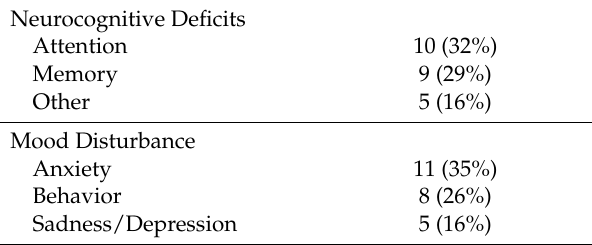
Table 3. Morbidities identified among 31 clinic